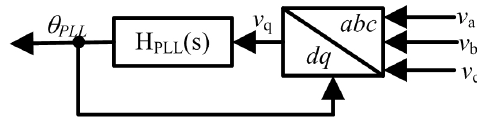
Figure 5. Block diagram of a SRF-PLL.